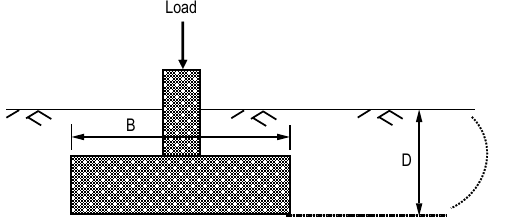
Fig. 1. A typical sketch for shallow